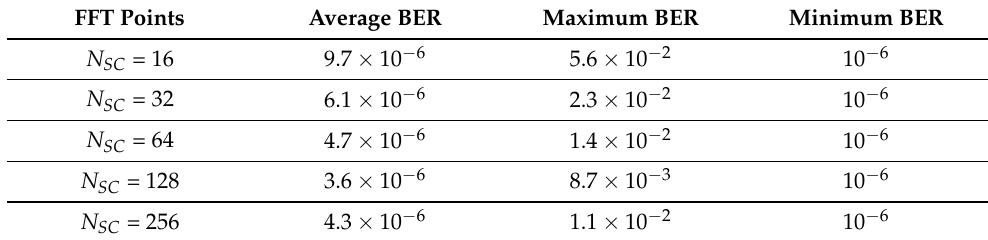
Table 3. BER performance as a function of N SC